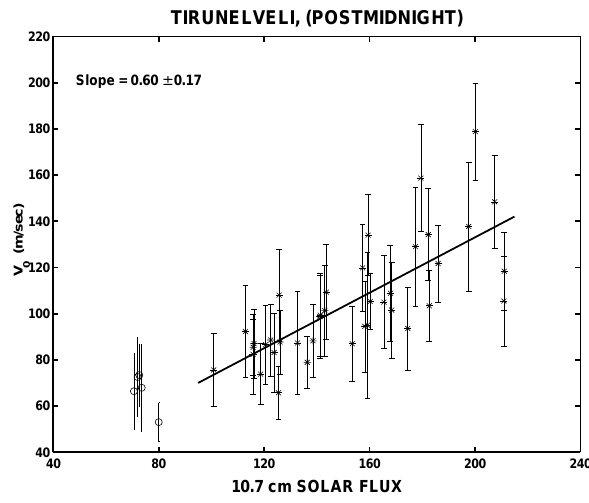
Fig. 8. Plot of average V 0 , for pre-midnight hours versus monthly average 10.7-cm solar flux (in units of 10 − 22 Wm − 2 Hz − 1 )